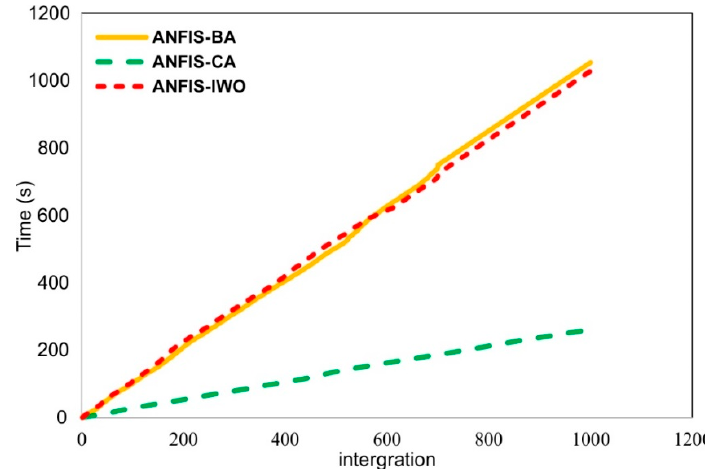
Figure 10. Cumulative curve of speed processing from applied models.